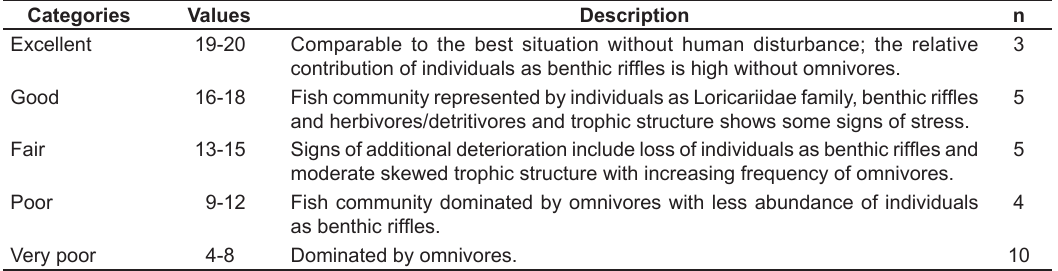
Table 7. Detailed descriptions of stream biotic integrity, IBI values and number of streams by category (n). Categories